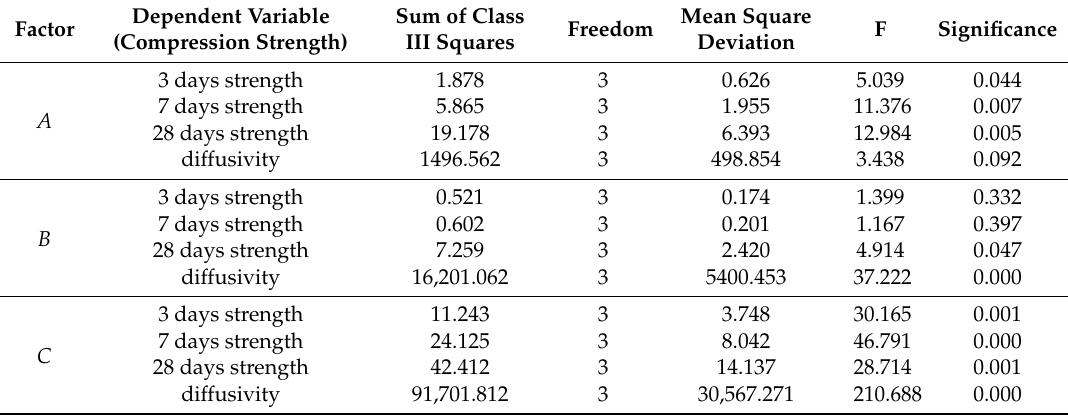
Table 5. Variance analysis of the compressive strength test and diffusivity